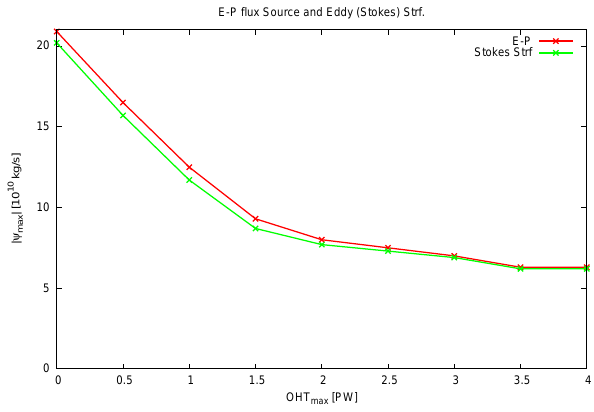
Figure 17. Eddy (E–P flux) source of the residual circulation and Stokes stream function (in 10 10 kgs − 1